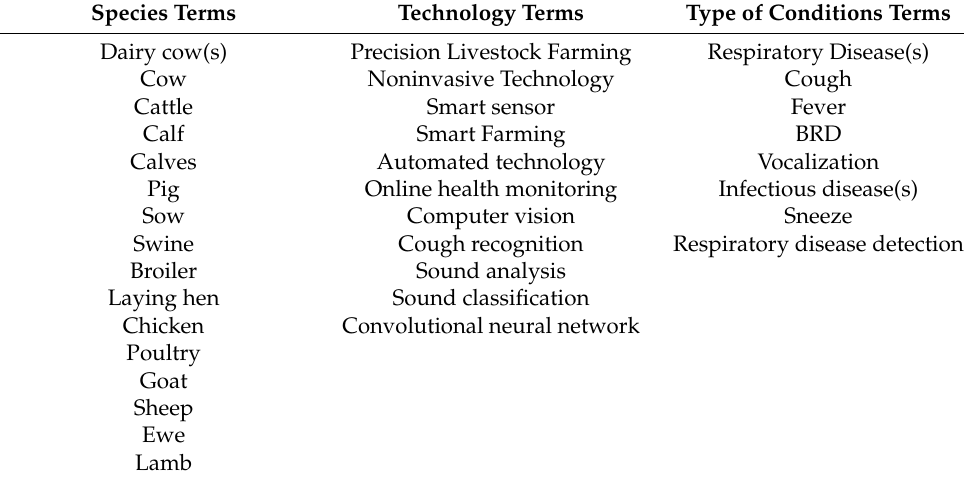
Table 1. Search strings for the literature